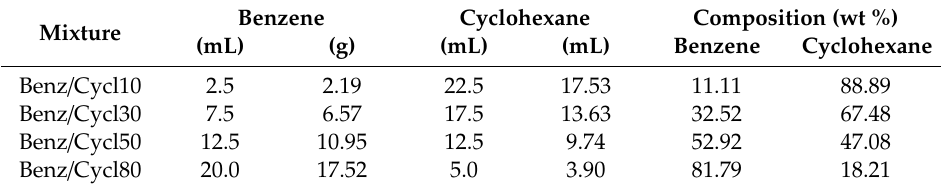
Table 1. Preparation conditions of the benzene / cyclohexane